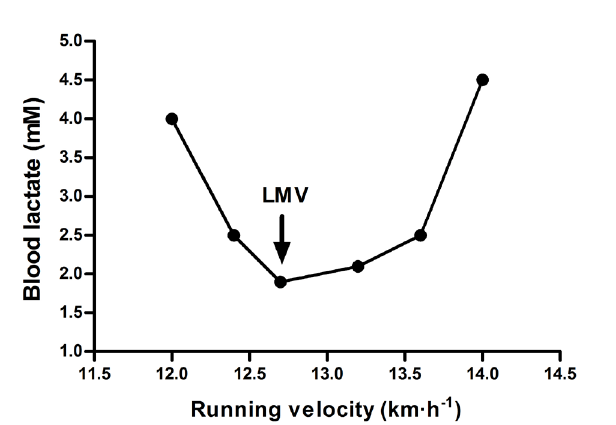
Figure 1. Example of lactate minimum velocity (LMV) determination in a single participant#1 (LMV= 12.7 km·h -1 ).